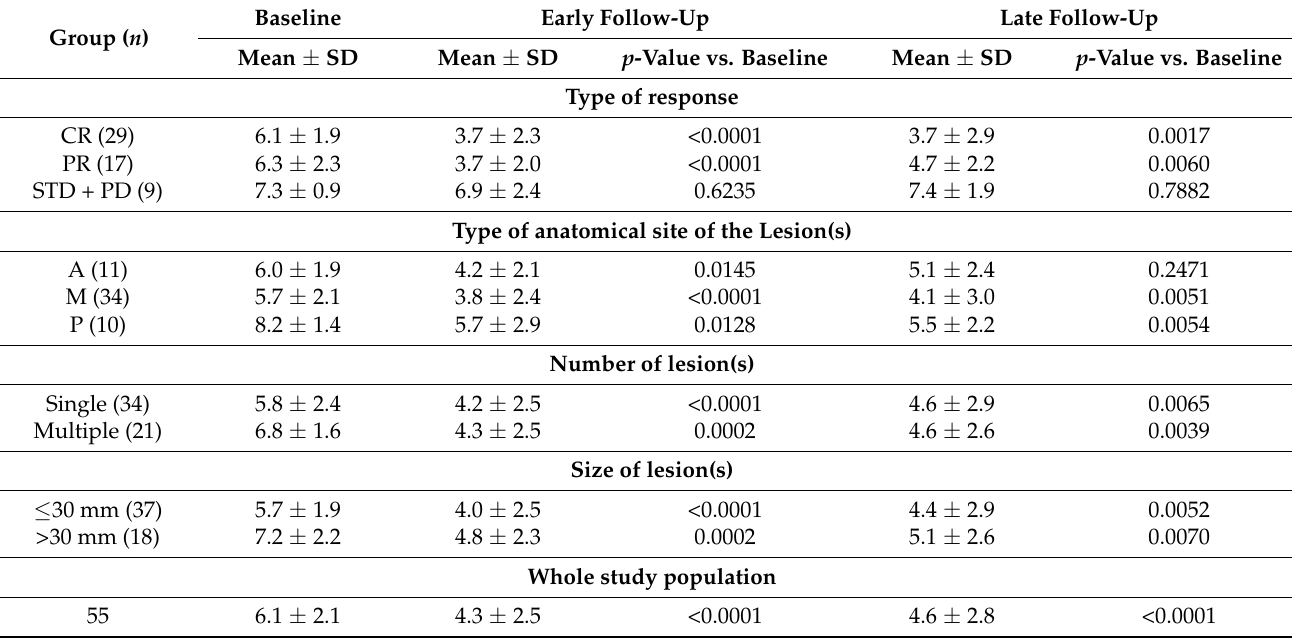
Table 1. Visual analog